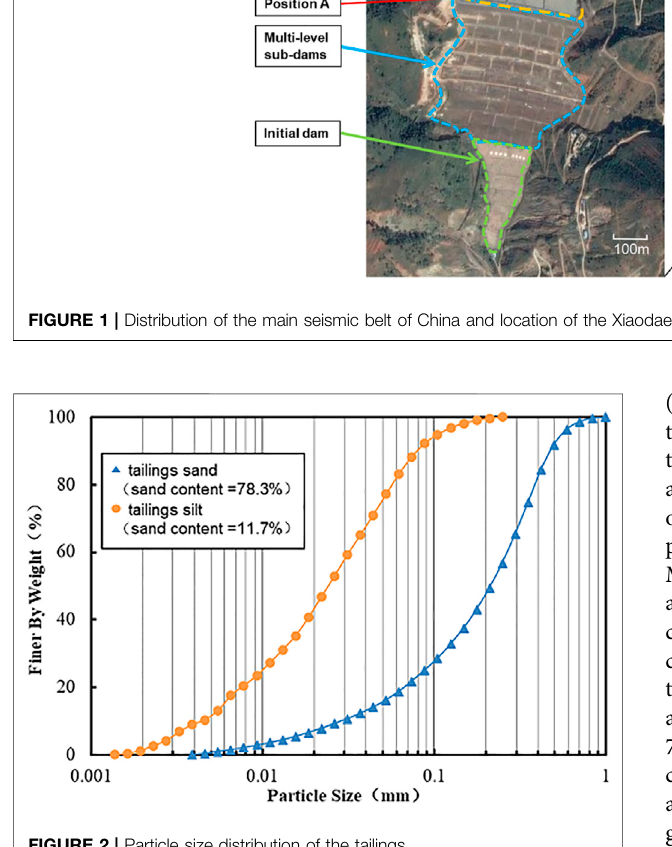
FIGURE 2 | Particle size distribution of the